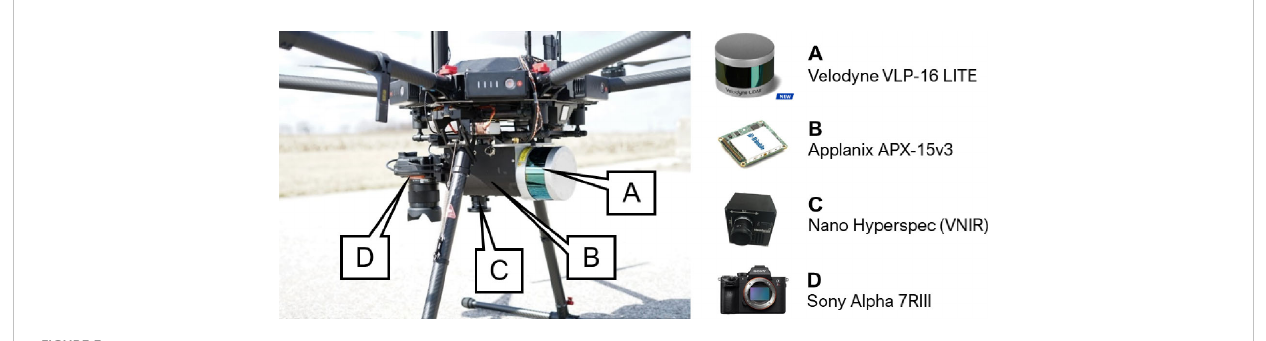
FIGURE 3 The Unmanned Aerial Vehicle (UAV) mobile mapping system and onboard sensors.